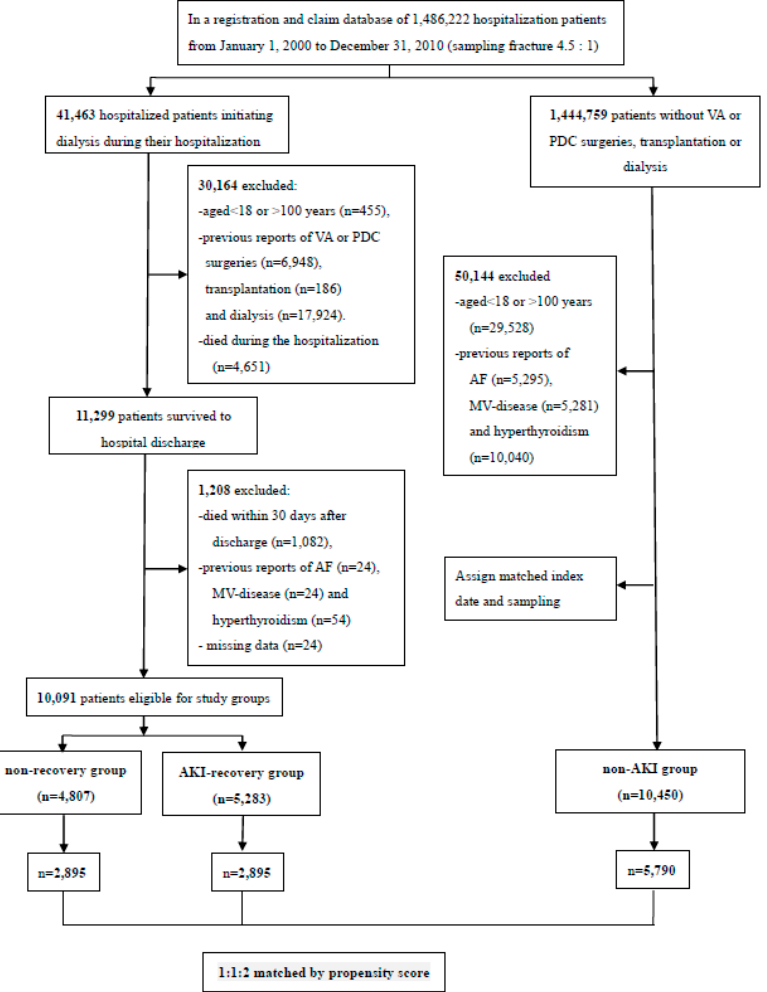
Figure 1. Study flow diagram. Abbreviations: AF, atrial fibrillation; MV, mitral valve; PDC, peritoneal dialysis catheter; VA, vascular access.